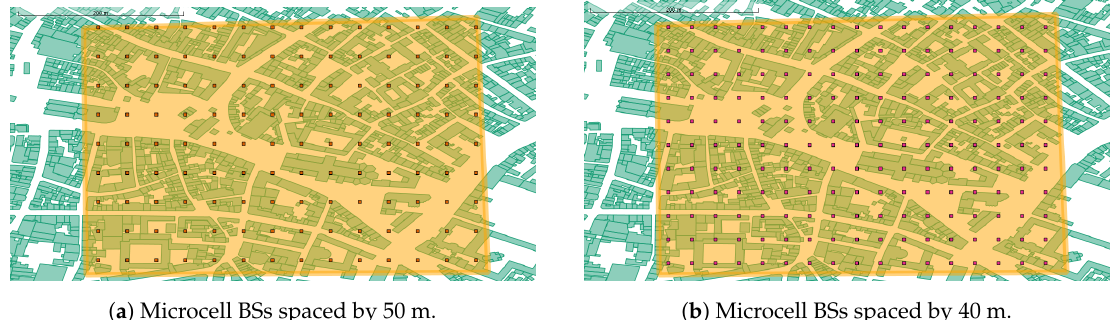
Figure 6. Configurations only with microcell BSs, spaced by 50 m ( a ) and by 40 m ( b ). The horizontal and vertical distances at which base stations are placed (50 m and 40 m) are chosen arbitrarily, taking into consideration the radio range of the used infrastructures, aiming at minimizing the uncovered area. The cell interference margin of the link budget (Table 1) is approximated as 4 dB and 5 dB for the configuration with base stations spaced by 50 m and 40 m,